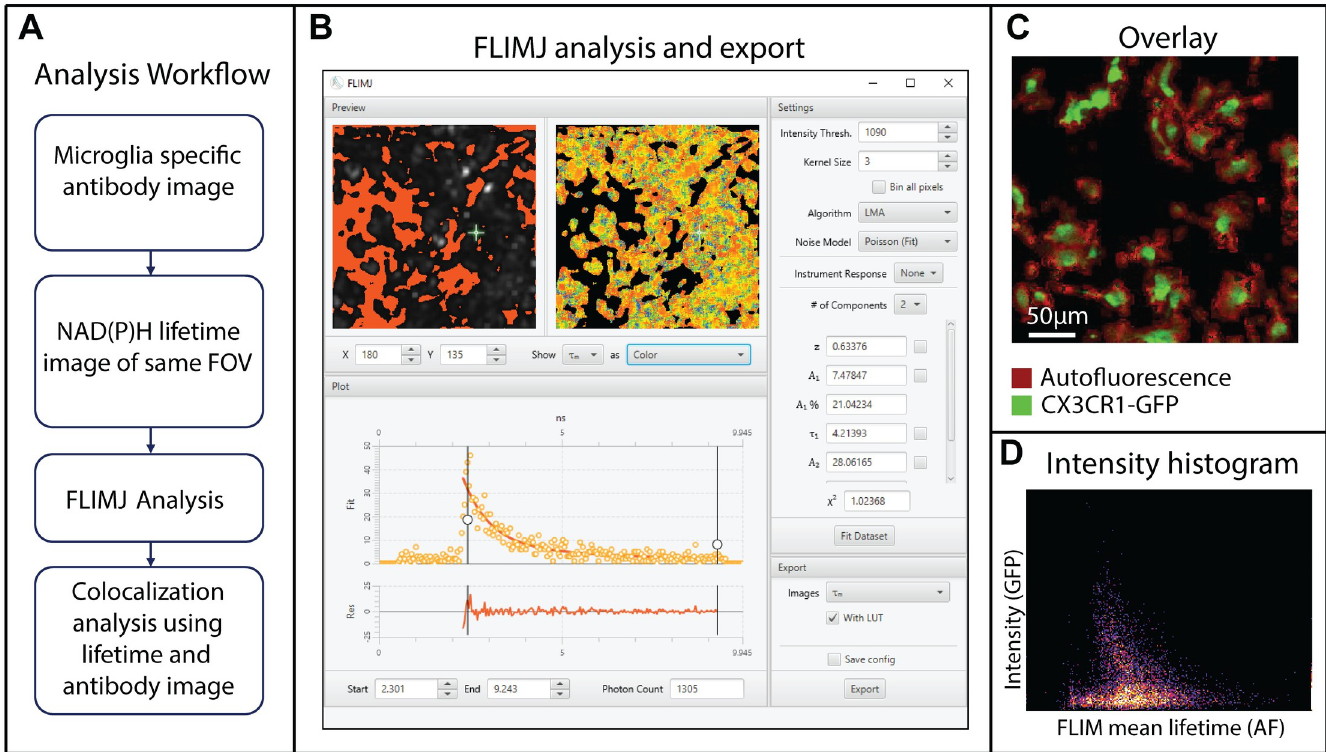
Fig 3. Microglia colocalization analysis using NADH FLIM and CX3CR1-GFP labels [39, 46]. A ) The analysis workflow describing how microglia are visualized using a specific antibody, followed by NADH FLIM acquisition and FLIMJ analysis B ) NADH FLIM data analysis using 2-component fit in FLIMJ-UI. Users can choose the intensity threshold, kernel size, fitting model, noise model, model restraints, and the number of components. The single curve fit is fast, and the “Fit Dataset” button performs fits for all the pixels. The fit result and fitting-parameters can be exported from the export tab on the lower right part of the UI. C ) Overlaid images of antibody (green) and lifetime image (red) to show the pixels with overlapping NADH and GFP signal. D ) Coloc2 analysis of mean lifetime and microglia antibody image.